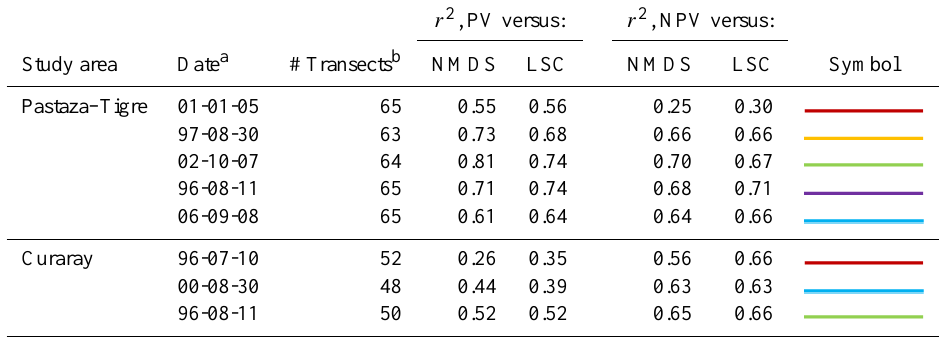
Table 1. Correlation coefficients ( r 2 ) for linear regressions of PV or NPV values against NMDS or LSC, by study area and Landsat image date (all values significant at P < 0 . 001). r 2 , PV versus: r 2 , NPV versus: